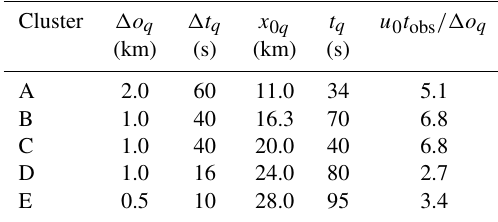
Table 1. Parameters of aerosol clusters.